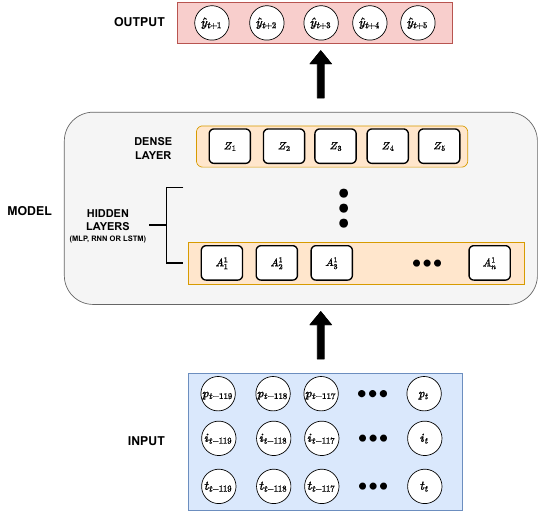
Figure 6. General neural network architecture developed for the present